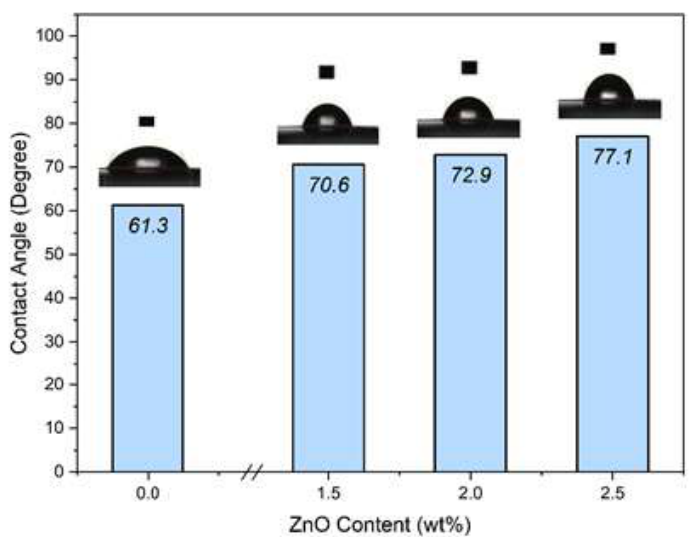
Figure 7: water contact angle for CA film and nanocomposite thick films with various ZnO content. The inset pictures show the images for the measurement of surface contact angles